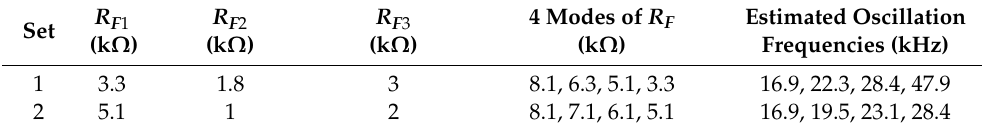
Estimated Oscillation Frequencies